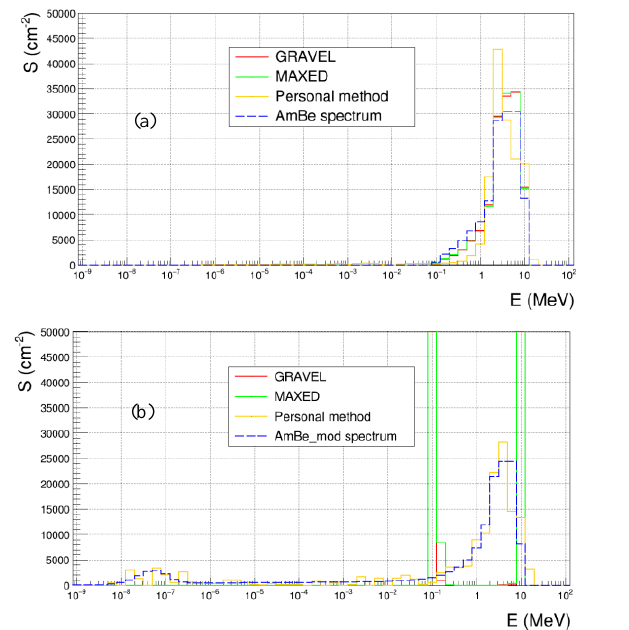
Fig. 6. Unfolding results (cm -2 ), as function of energy (MeV), with a flat guess spectrum and high statistics (Φ = 1.41×10 5 cm -2 ). (a), unmoderated Am/Be source. (b), moderated Am/Be source.